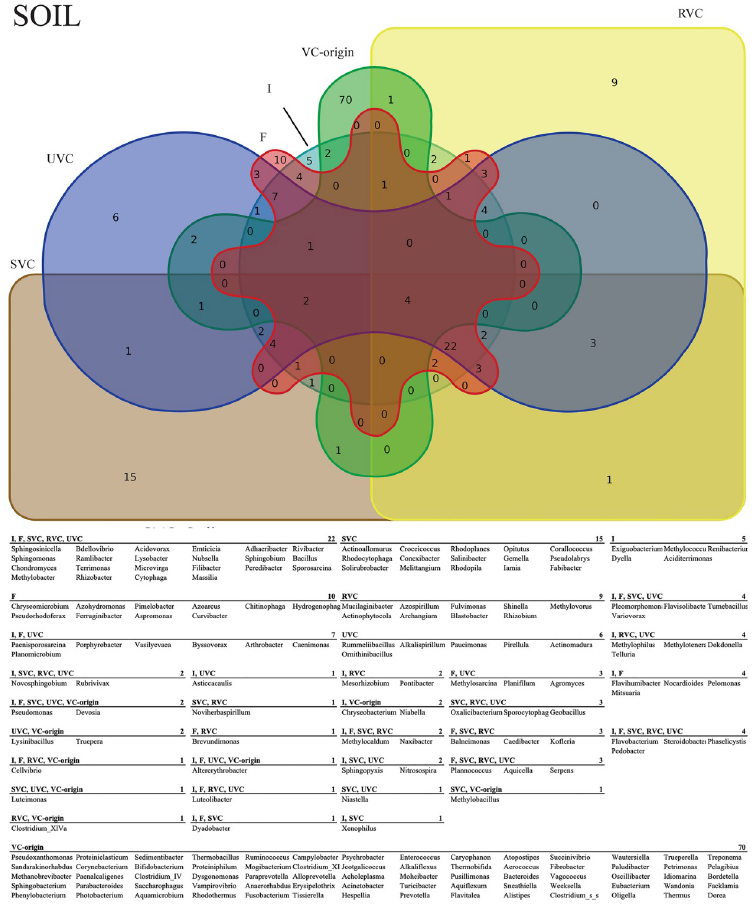
Fig 3. Soil rhizosphere taxa diagram. Venn diagram of observed genera across all treatments in soil. The associated table lists genera corresponding to treatment-specific and shared taxa.